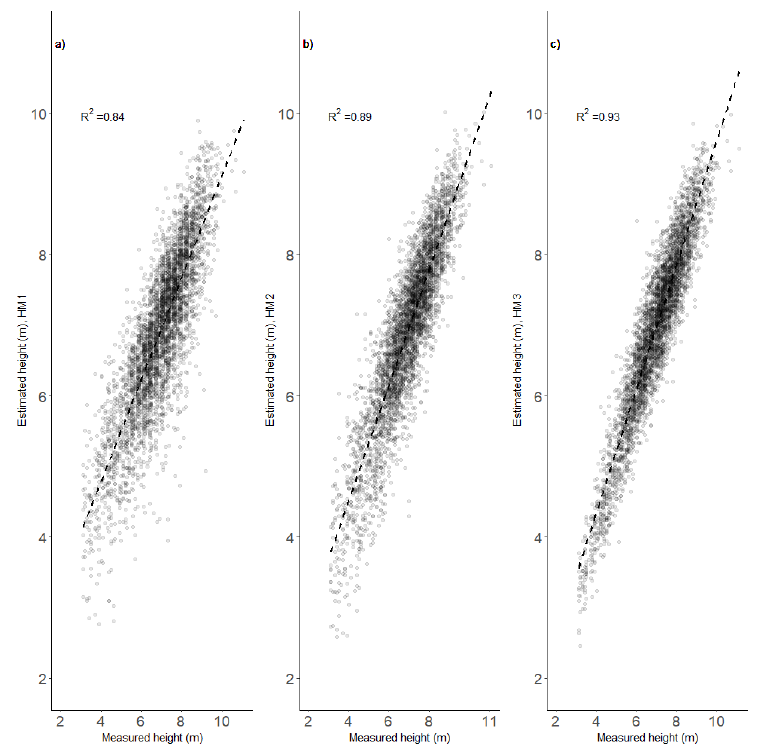
Figure 2. Linear fits between manual measurements and image-based estimates of height at the age of 12 years provided by three developed models (HM1—( a ), HM2—( b ) and HM3—( c )). Forests 2020 , 11 , x FOR PEER REVIEW